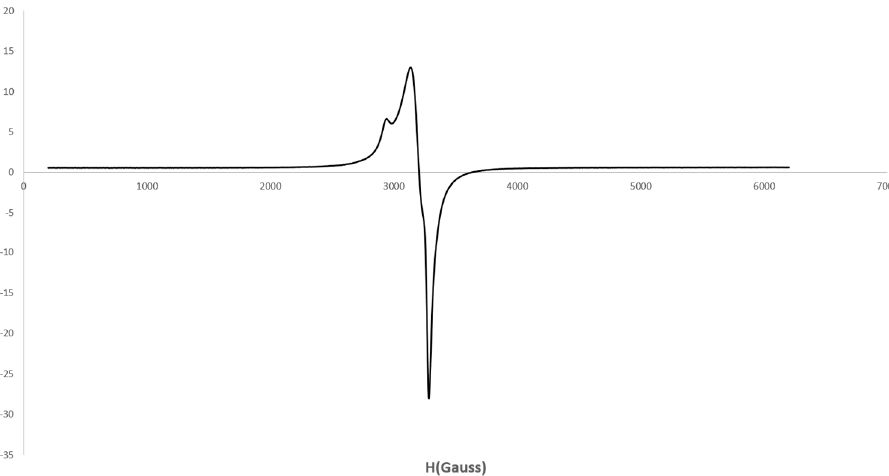
Figure 2. EPR spectrum for Cu(II) complex .